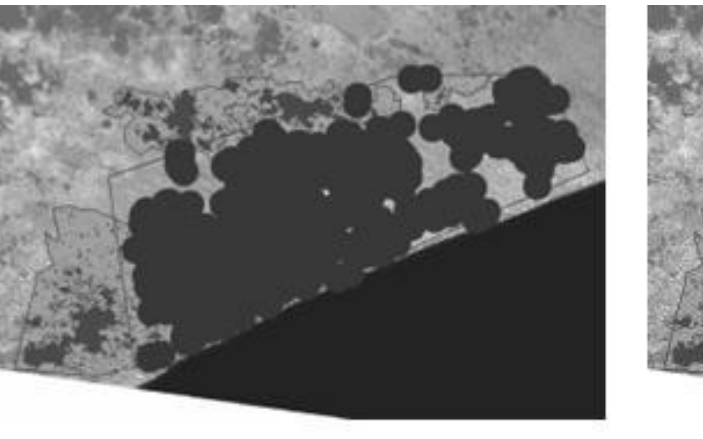
Fig. 8 . Images showing crop pollination areas, i.e., the area being serviced by pollinating bees based on forest patches ‡ 1 ha in the Madagascar case study. On the left, the area is serviced under the assumption that the distance within which most pollinator foraging occurs is set to 1400 m. On the right, the area is serviced with much more restricted foraging of < 400 m (see Bodin et al.